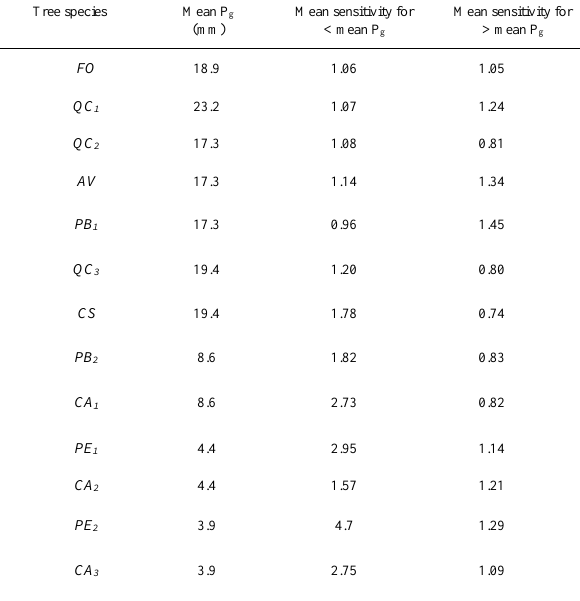
Table 4. Throughfall (TF) sensitivity coefficients classified for storm magnitudes (P g ) smaller and larger than mean P g